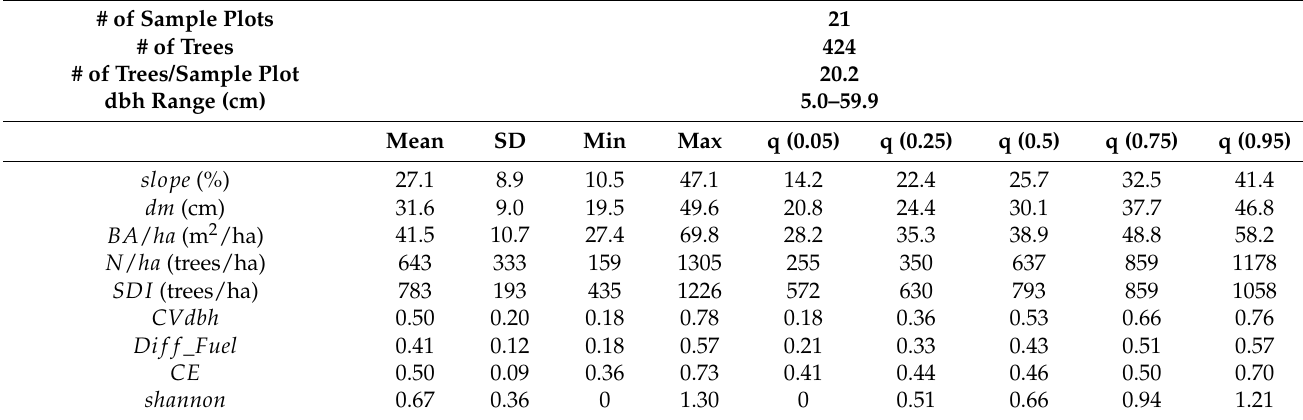
Table 1. Summary statistics of sample plots: slope , slope of sample plot; dm , diameter of mean basal area tree; BA / ha , basal area per hectare; N / ha , number of trees per hectare; SDI , stand density index; CVdbh , coefficient of variation of diameter at breast height; Dif f _ Fuel , dbh differentiation according to Füldner; CE , Clark and Evans aggregation index; shannon , Shannon